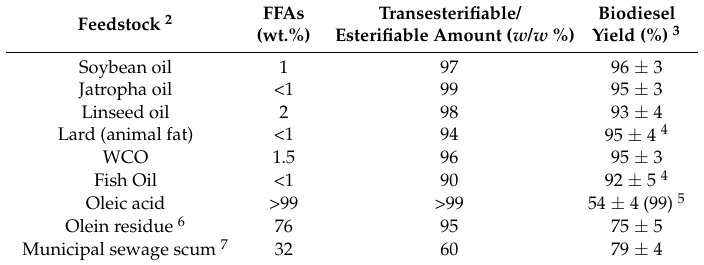
Table 2. ZnO/TBAI catalyzed biodiesel production from refined and waste lipid feedstocks 1